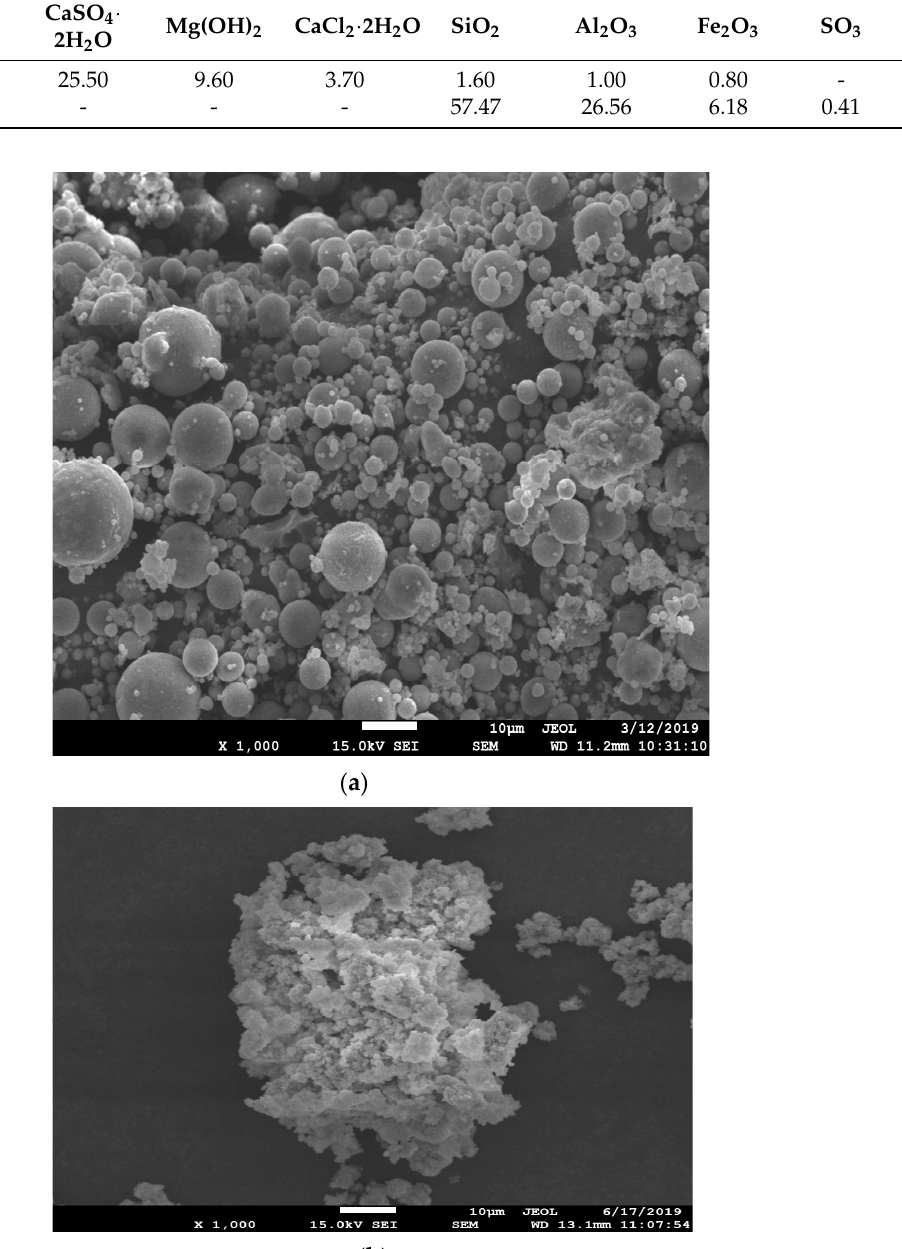
Figure 3. Particle size distribution of ASR and FA. 2.2. Specimen Preparation To form MOC paste, caustic burnt magnesia with 82.53 wt.% active magnesium oxide and magnesium chloride halide with 48.0 wt.% magnesium chloride were adopted in compliance with QB/T 2605 [24]. The proportions of caustic burnt magnesia (3.58 g/cm 3 ), magnesium chloride halide (1.56 g/cm 3 ) and water (1.00 g/cm 3 ) were optimized as 8:1:12 following previous research [8]. To explore the influence of FA on the properties of MOC pastes, four groups were designed incorporating 10%, 20%, 30% and 40% FA by weight, denoted as Groups A1, A2, A3 and A4. Detailed mix proportions are displayed in Table 2. In contrast, a control group, Group O, of plain MOC paste with no FA addition was prepared to compare the property change in fresh and hardened states of the composites. Mixtures were cast into 40 × 40 × 160 mm 3 prismatic molds for flexural strength evaluation (three specimens for each group), and a total of six broken specimens for each group were used for the compressive strength test [25]. Moreover, three specimens with a size of 25 × 25 × 280 mm 3 were adopted for free deformation tests in each group [26]. These specimens were wrapped in plastic films for 24 h at room temperature before demolding and there- after cured under 20 ± 2 °C and 70 ± 5% relative humidity till the ages for testing. Such curing conditions were determined to simulate the local climate and humidity conditions.